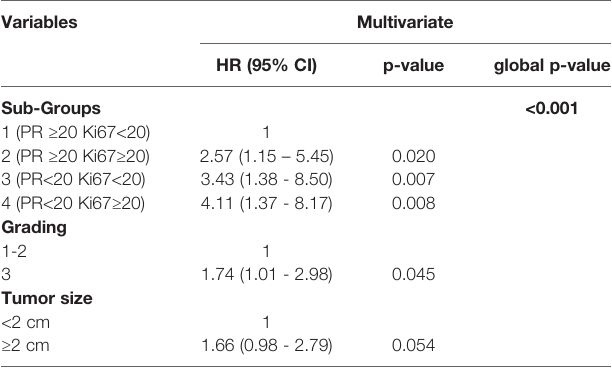
TABLE 4 | Prognostic variables for breast cancer speci fi c-survival in multivariate